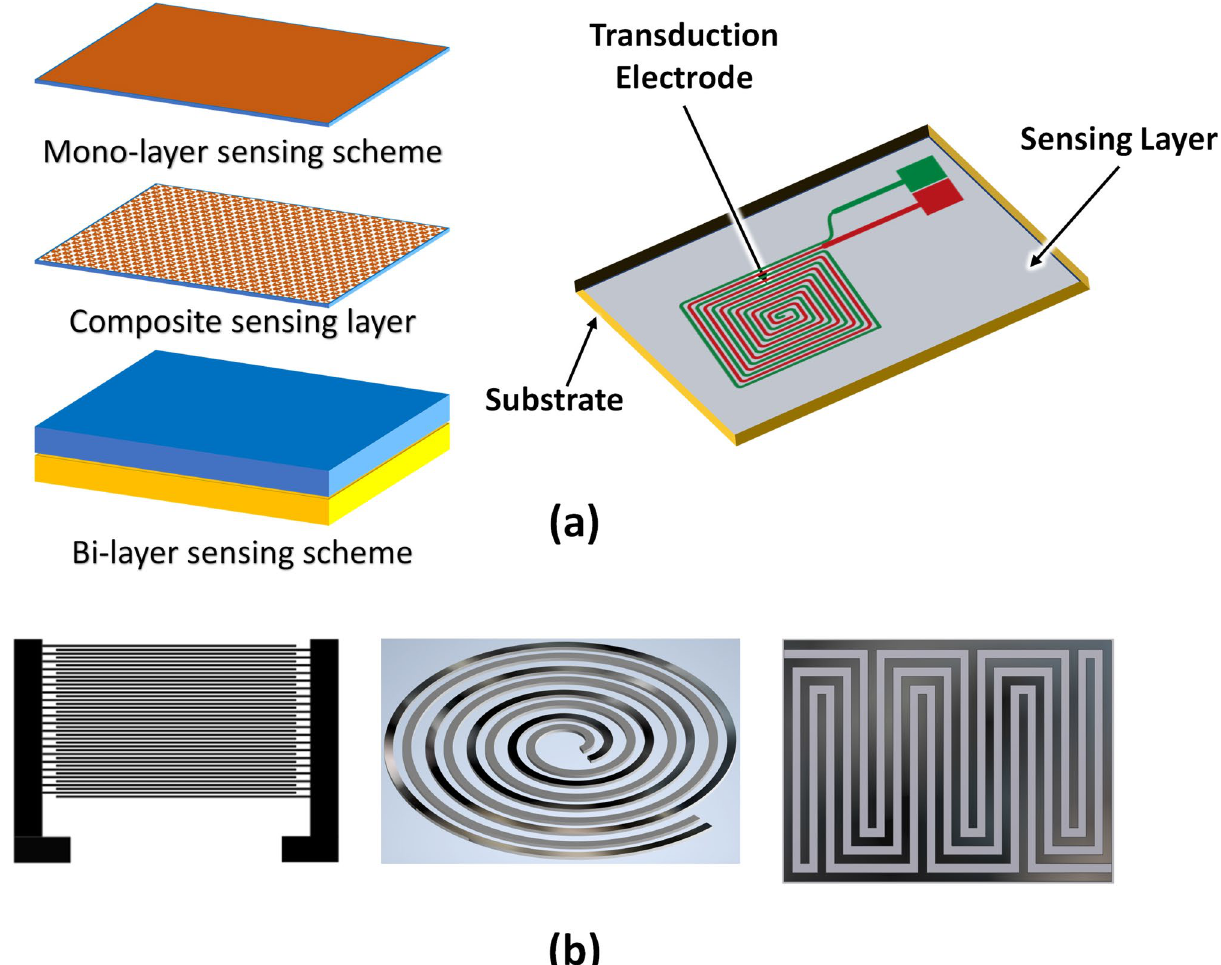
Figure 1. ( a ) Typical sensing mechanism of an electrochemical sensor. ( b ) Geometric shapes of transduction